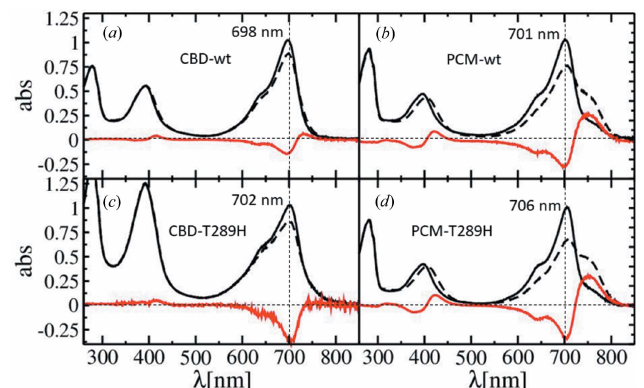
Figure 3 Absorption spectra of SaBphP1 constructs where the Pr to Pfr transition has been initiated with 660 nm light. Black solid line: illumination by 740 nm, black dashed line: illumination by 660 nm, red line: difference spectrum. Absorption maxima wavelengths are marked. Dashed horizontal lines mark zero absorption, vertical dashed lines mark the 700 nm wavelength. ( a ) CBD wild type, ( b ) PCM wild type, ( c ) CBD T289H mutant, ( d ) PCM T289H